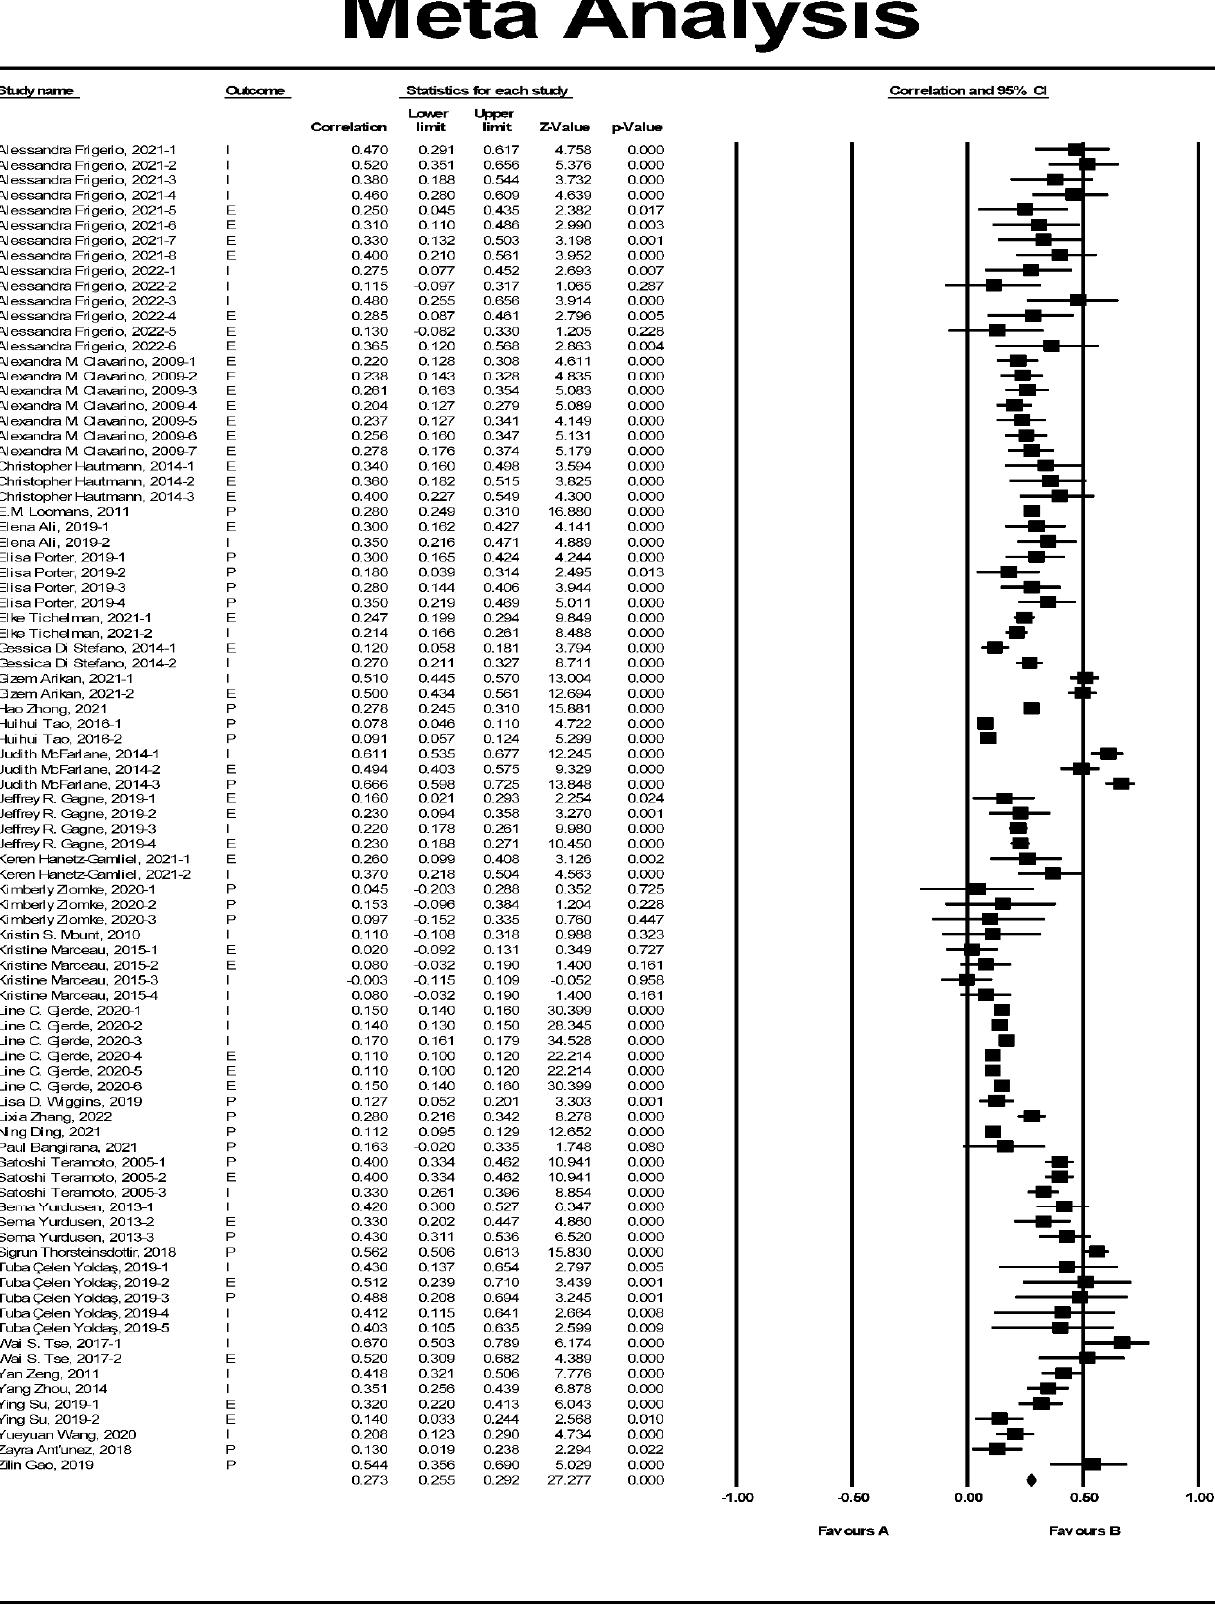
Figure 3. The forest map of the effect of problem behavior [2,15,22–24,29–57].